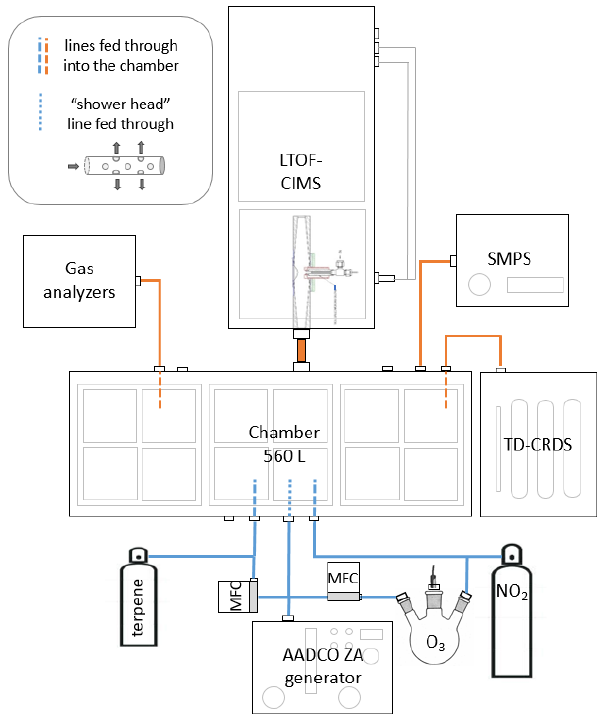
Figure 2. Experimental setup for chamber studies. Blue lines indi- cate flow going into the chamber, and orange lines indicate where flow is being